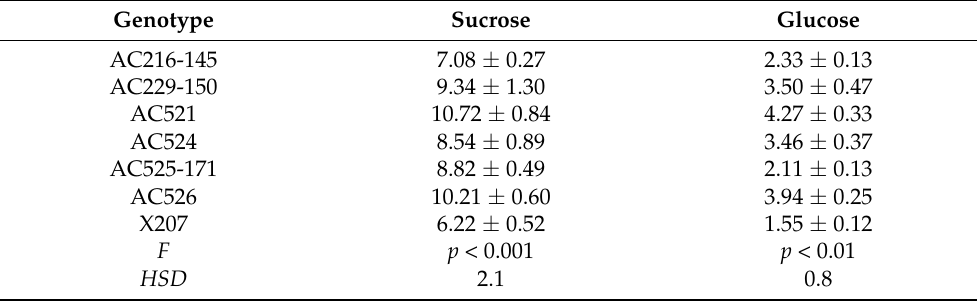
Table 3. Malate and citrate contents in roots of six different accessions and the X207 hybrid ( P. ahipa × P. tuberosus ). Means in % dry weight ± standard deviation. Significance of Snedecor’s F for the genotypic source of variation and Tukey’s HSD test.